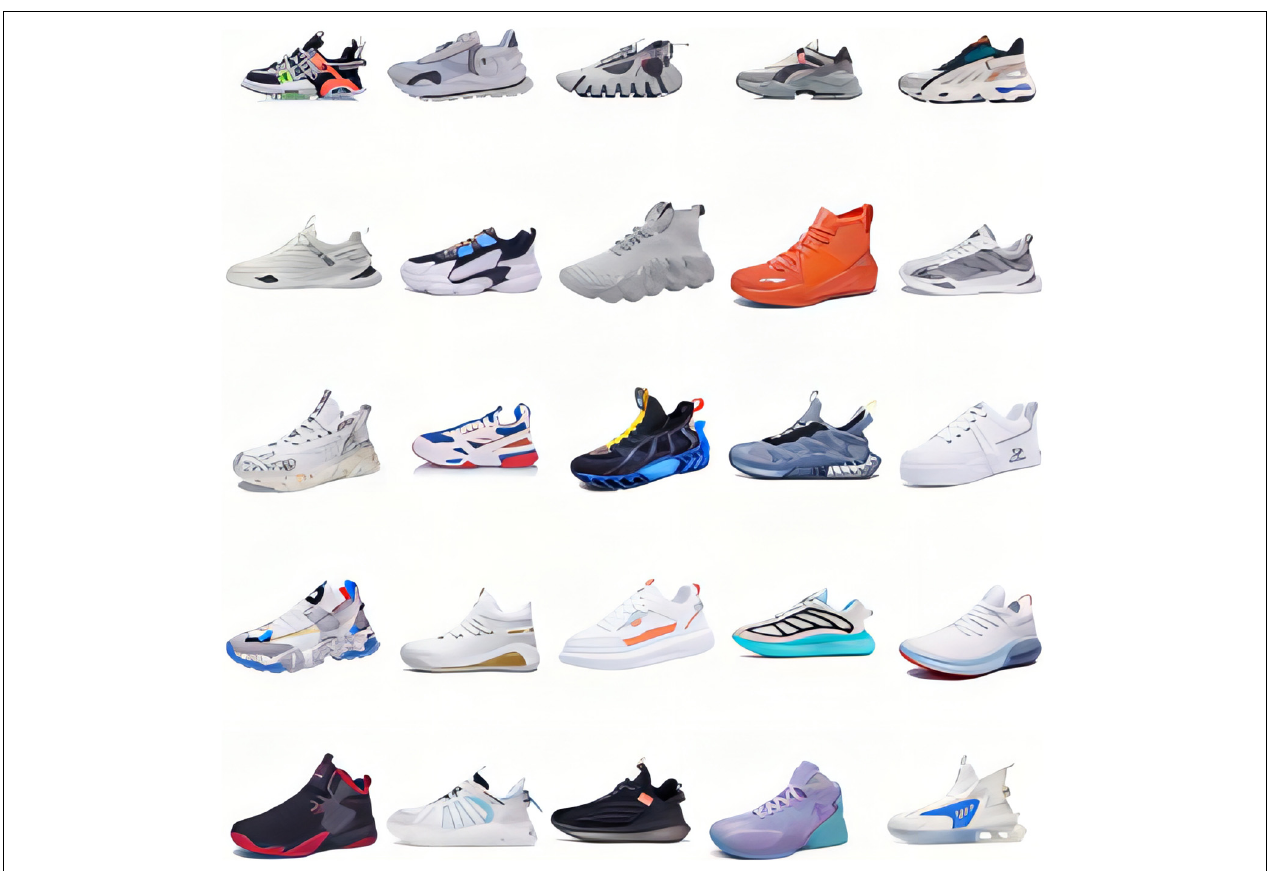
FIGURE 1 | Images of 25 different sport shoes used in the experiment.